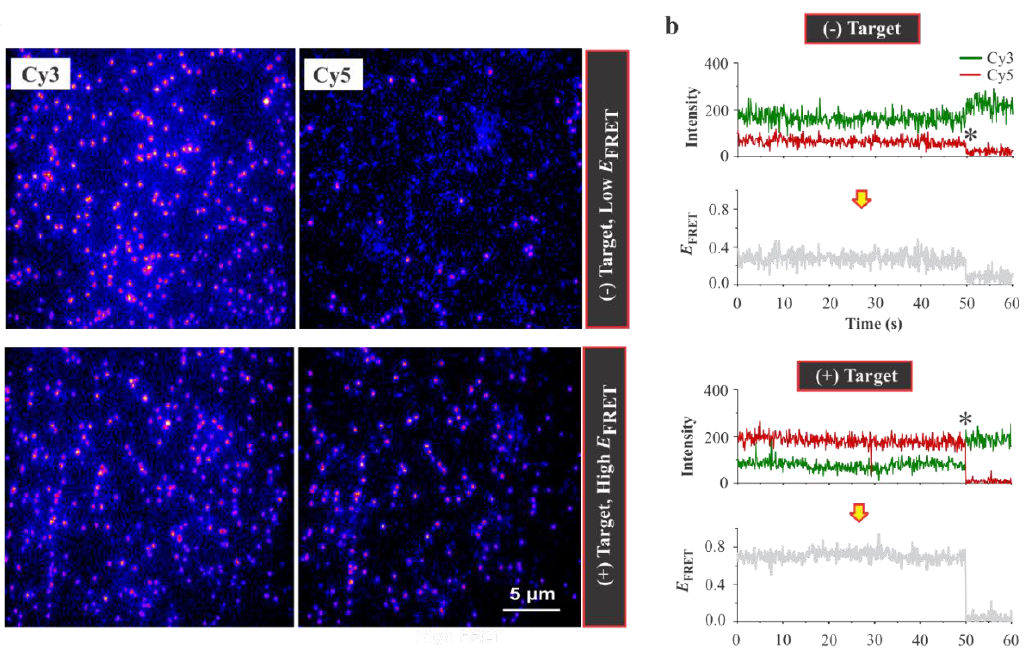
Figure 2. Single molecule visualization of lysozyme binding. ( a ) Fluorescence snap-shots of the surface-immobilized aptasensors before (top) and after adding 0.3 µ M lysozyme (bottom). The Cy5 channel lit up significantly after adding lysozyme, which demonstrated an increase in the FRET e ffi ciency due to lysozyme dependent conformational switch of the aptasensors. Scale bar 5 µ m. ( b ) Typical single molecule traces. Top: Open conformation (low-FRET e ffi ciency ( E FRET ) state); Bottom: Closed conformation (high- E FRET state). The fluorescence intensities of the donor (Cy3: green) and the accepter (Cy5: red) fluorophore and the corresponding FRET e ffi ciencies are shown for both conformations. The asterisks indicate the photobleaching event of the Cy5 fluorophores. All of the experiments were performed in 1 × TAE-Mg bu ff er at 23 ◦